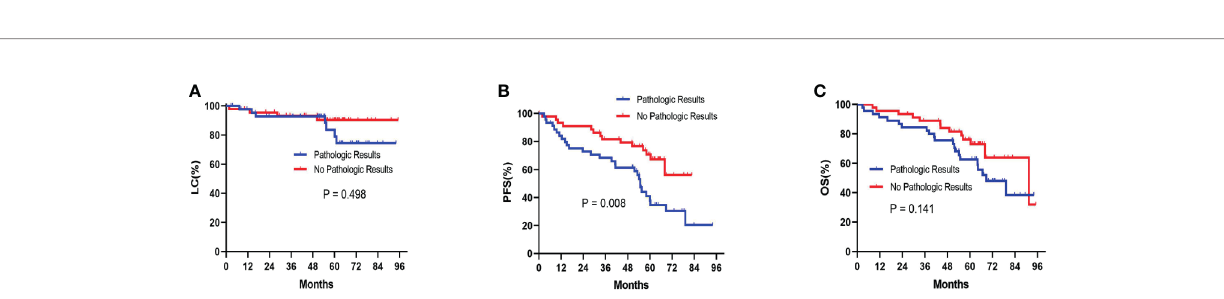
FIGURE 2 | Kaplan-Meier survival analysis before the PSM analysis for LC (A) , PFS (B) , and OS (C) between patients with pathologic results and patients with no pathologic results. PSM, propensity score matching; LC, local control; PFS, progression-free survival; OS, overall survival.